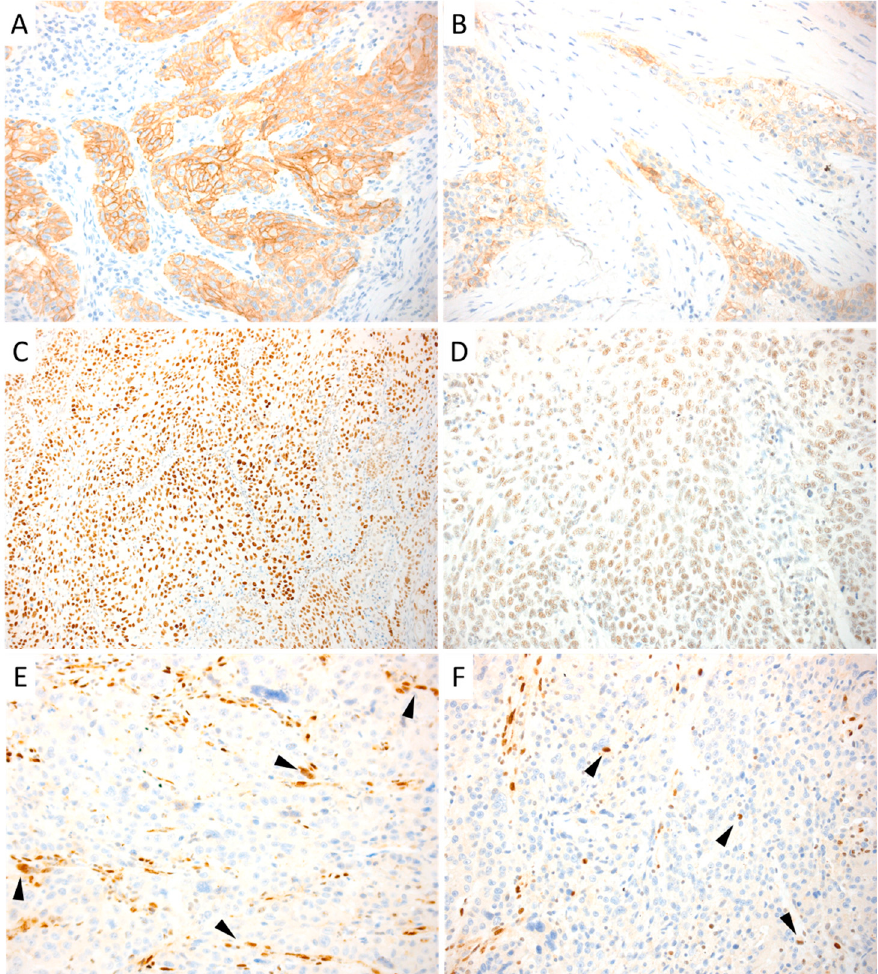
Figure 1. Representative cases of positive immunohistochemistry stain. Cancer cells showing strong membrane immunoreaction for E-cadherin ( A ) and N-cadherin ( B ); nuclear expression for Snail ( C ), Slug ( D ), Zeb1 ( E ), and Zeb2 ( F ). Note that Zeb1 and Zeb2 resulted in a patchy stain pattern in all cases (arrowheads). A, B, C, D, E, F: Original magnification: